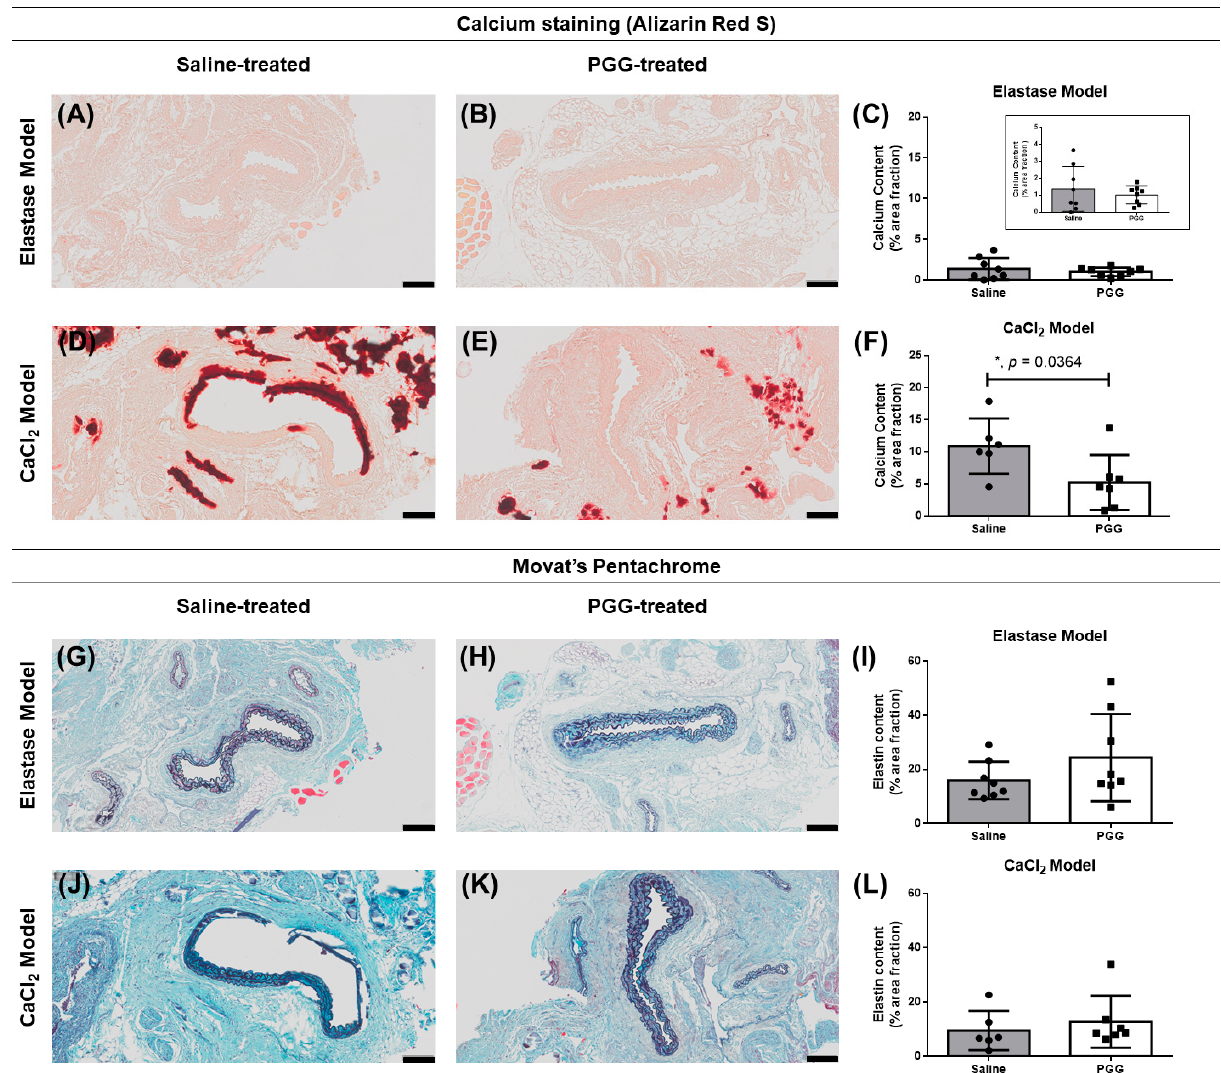
Figure 6. Histological characterization of abdominal aorta specimens obtained from elastase and CaCl 2 -treated animal models of aortic injury. Alizarin Red S-based staining and semi-quantitative estimation of calcium (dark red) in specimens from the elastase ( A – C ; inset is the zoomed in view of Figure 6C) and CaCl 2 model ( D – F ). Movat’s Pentachrome stained sections and their respective semi-quantifications for elastin (dark violet to black) from all four groups, elastase + saline vs. elastase + PGG ( G – I ) and CaCl 2 + saline vs. CaCl 2 + PGG ( J – L ), are shown here. Calcium content was found to be significantly lower (almost twice) in the PGG-treated cohort as compared to their saline counterpart in the CaCl 2 -injured group ( p = 0.0364), with almost no change in the elastase groups ( p > 0.05; C & F ). Elastin content was not significantly different between the saline-treated vs. PGG-treated cohorts of either injury models ( p > 0.05; I&L). Scale bar = 100 µm.